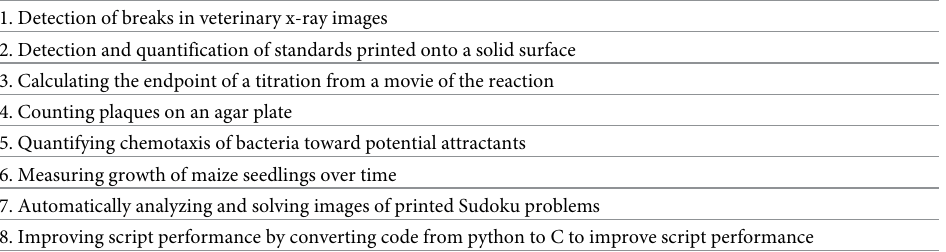
Table 1. Example pair programming and independent research